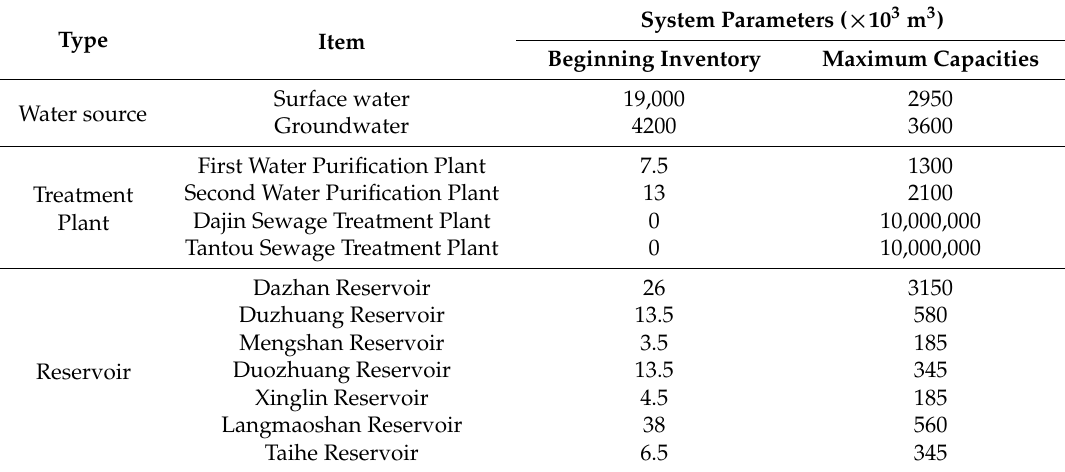
Table 1. The parameters related to water sources, treatment plants and reservoirs.